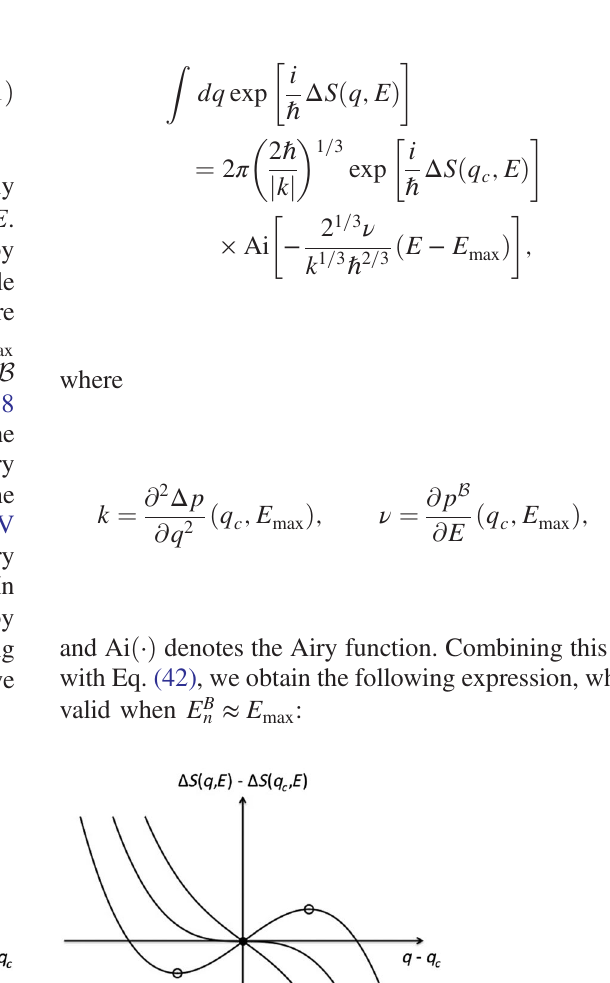
. The open circles correspond to intersection points between A and B when E < E max (solid circle), and for E > E max